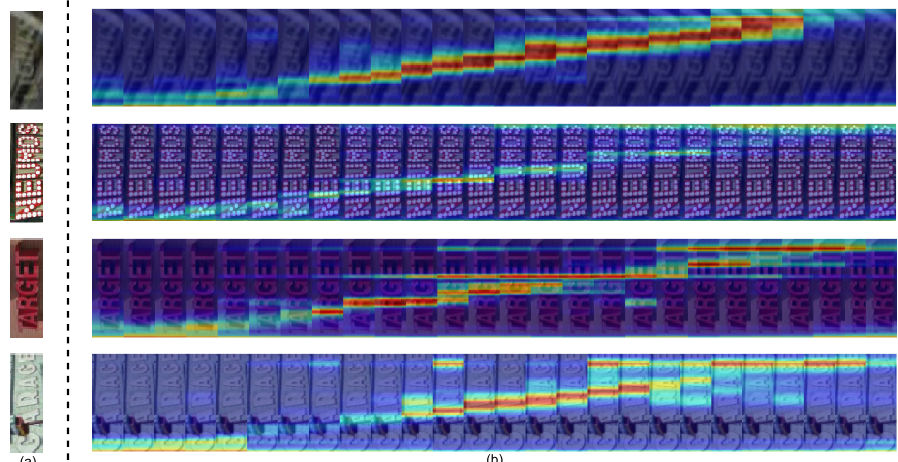
Figure 7. The attention visualization of TFE. ( a ) Examples of rectified images. ( b ) The attention map of initial embedding and each embedding in feature map extracted with the transformer encoder.